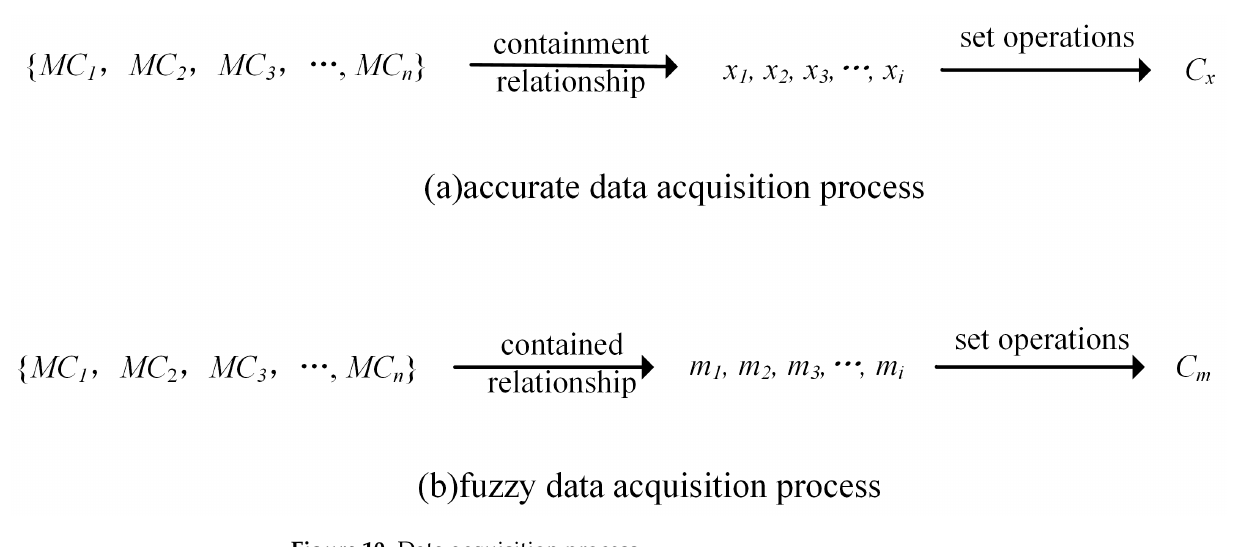
Figure 10. Data acquisition process. Table 5. Corresponding codes for different queries.